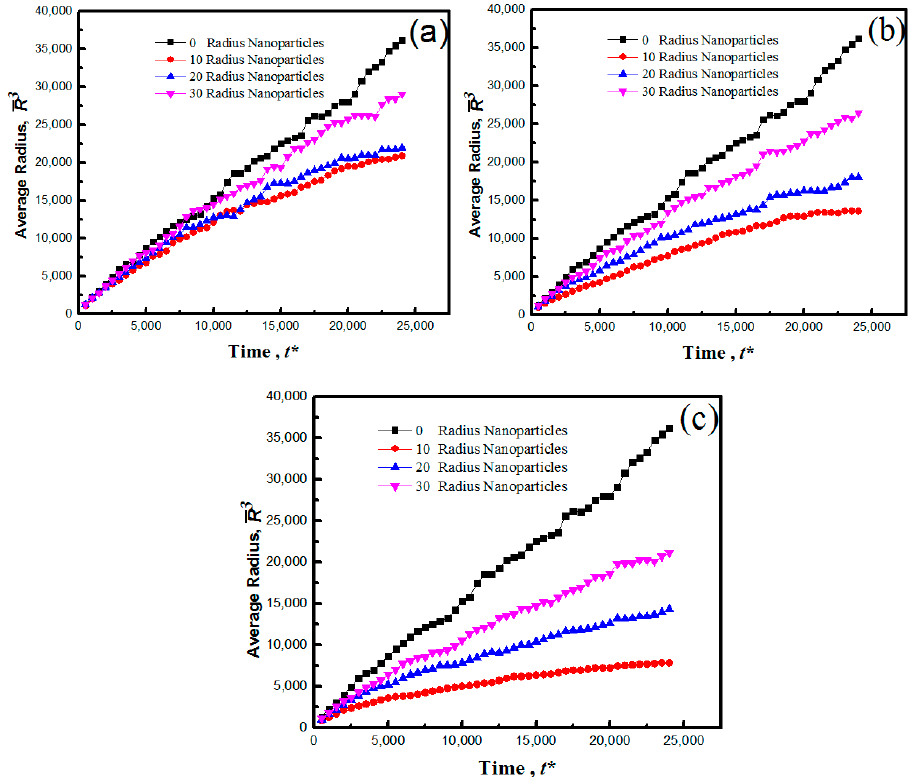
Figure 11. Plots of the cube of the average precipitate radius with time for different nanoparticles area fractions of: ( a ) 10%, ( b ) 20%, and ( c ) 30%. Particle sizes are labeled in the